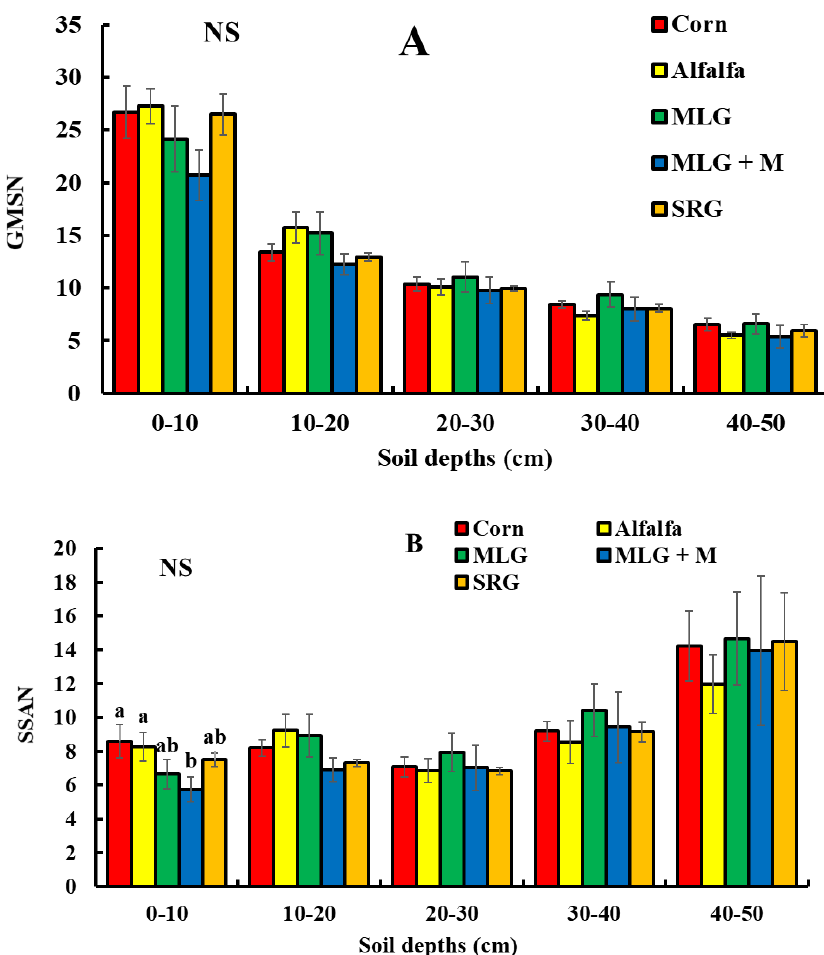
Figure 7. Changes of GMSN ( A ) and SSAN ( B ) under different land uses. GMSN represent geometric means of LOC and available nutrients. SSAN represent sum scores of LOC and available nutrients. The bars represent standard errors. Values without a common letter within land use treatments differed according to the LSD test ( p < 0.05). NS = not significant among different land uses.